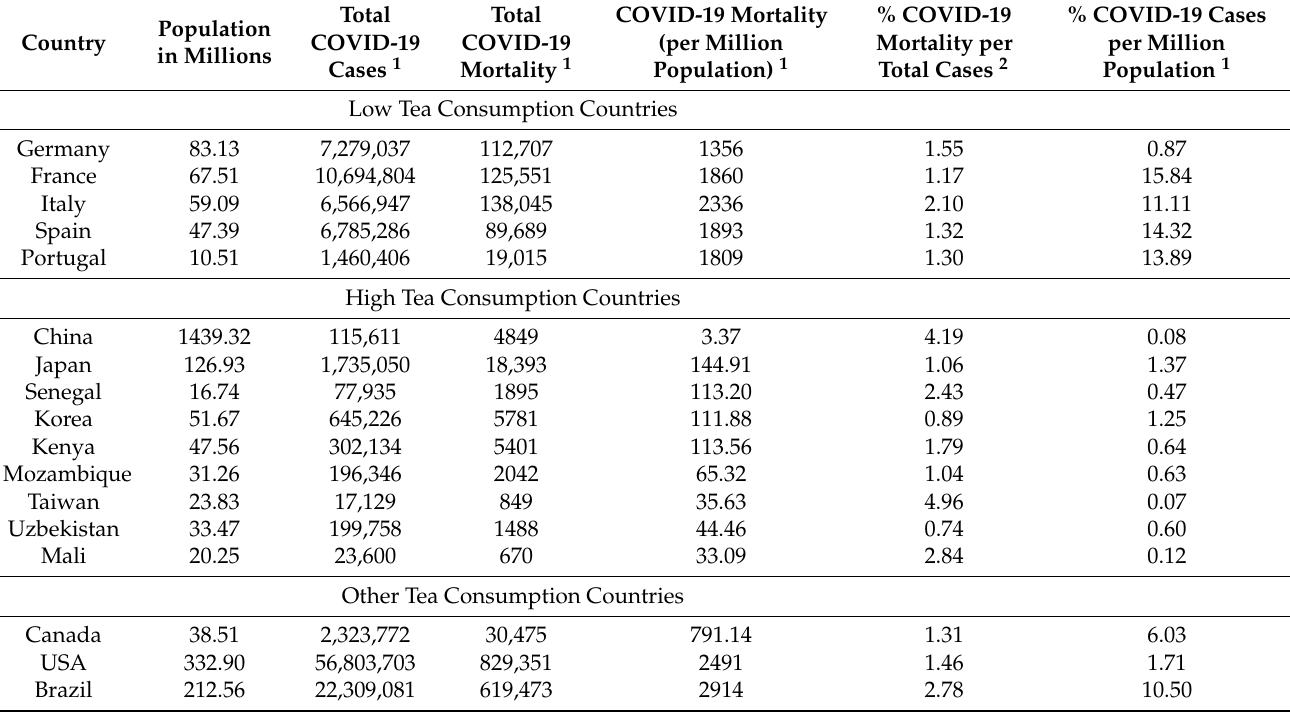
Table 3. Countries with “low” and “high” (above 150 g per/capita) tea consumption relative to the total COVID-19 mortality per millions of people and percentage of COVID-19 mortality per total infections in different